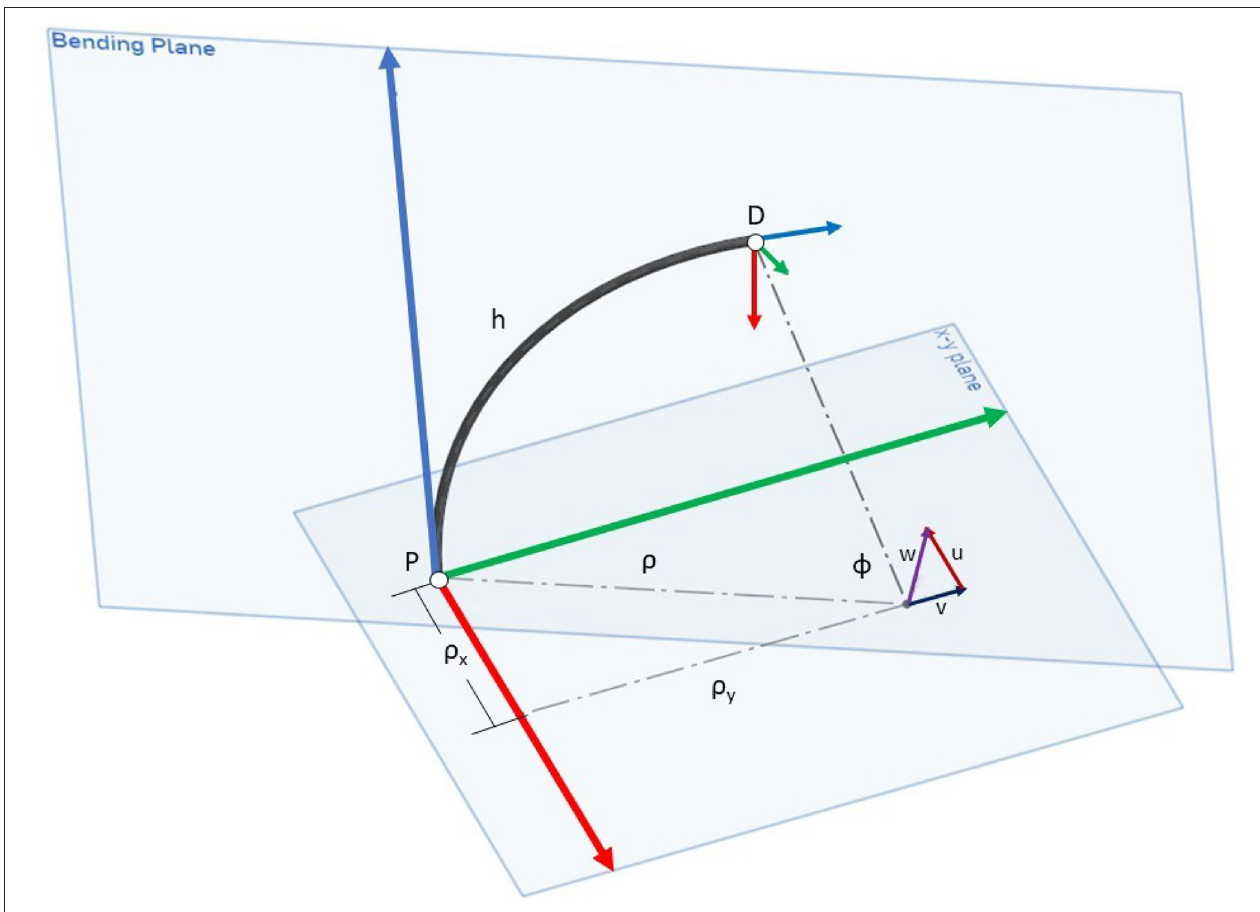
FIGURE 2 | The parametrization variables used to describe a constant curvature continuum segment in our work. Developed by Allen et al.